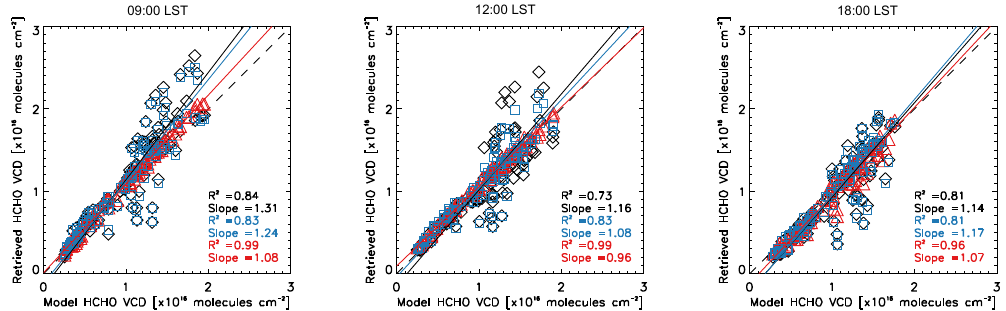
Figure 4. Comparison of the retrieved versus simulated VCDs shown in Fig. 3 over China (105–120 ◦ E, 15–45 ◦ N). Black diamonds, red triangles, and blue squares denote the retrieved VCDs using AMF m , AMF h , and AMF mh , respectively. Statistics are shown as insets.